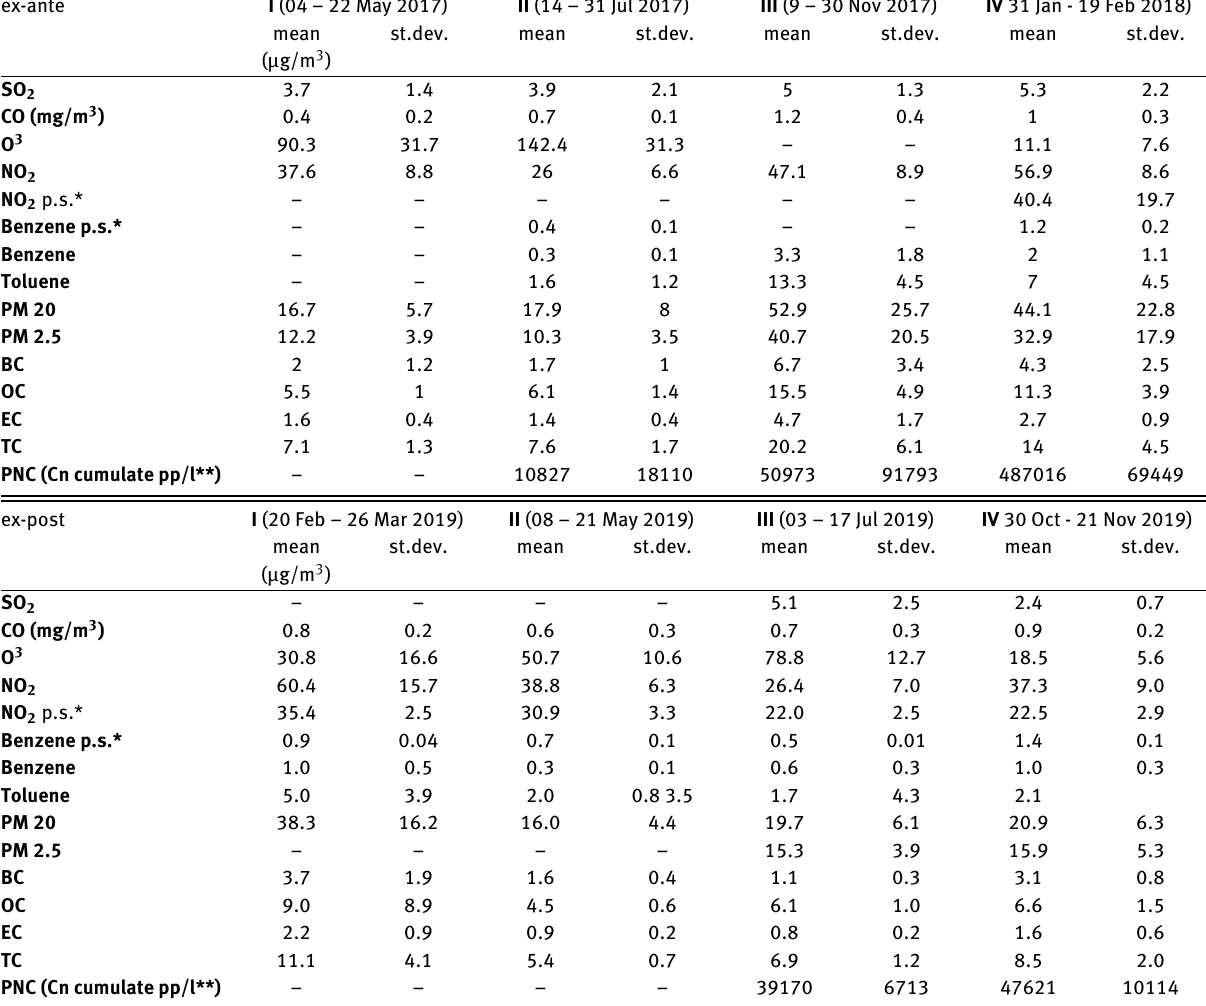
Table 4: Ex-ante and ex-post summary of the hourly pollutant concentration statistics (mean and standard deviation) at the four sites